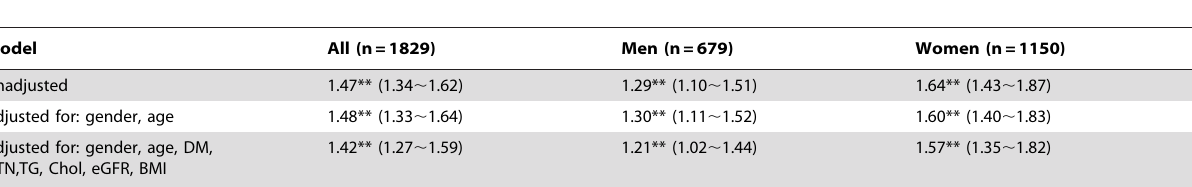
Table 4. Odds ratio for MAU by uric acid treated as a continuous variable.